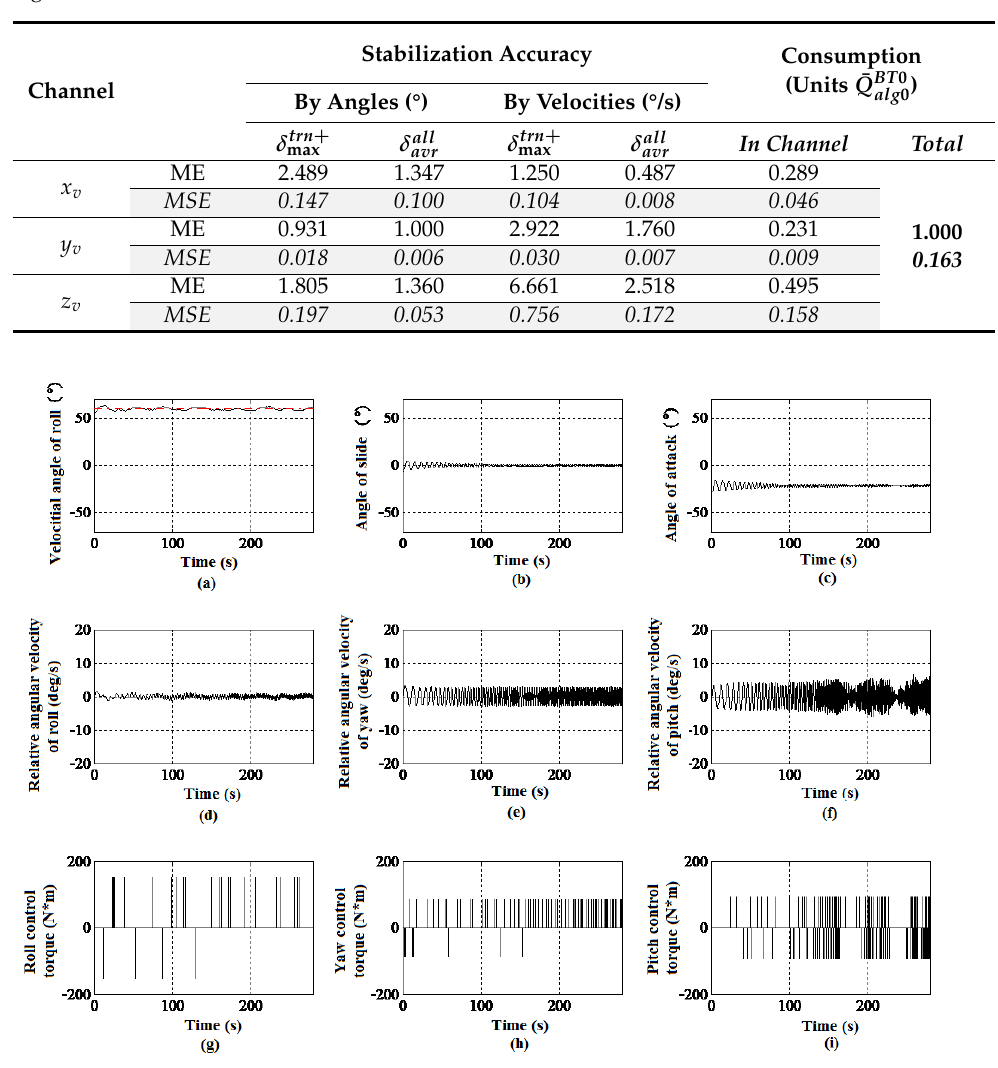
Figure 3. Typical process of stabilization of the lander without roll overturns according to the standard